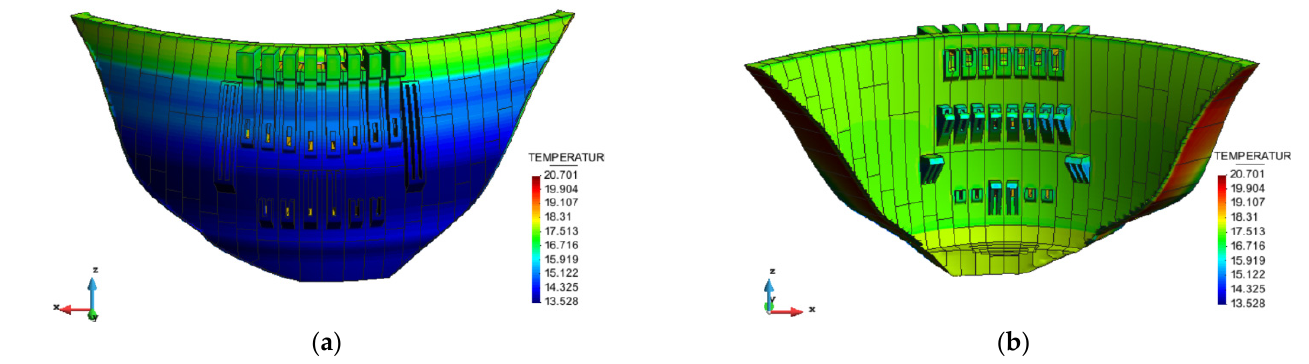
Figure 16. Cloud map of quasi-stable temperature field distribution of the dam in April (unit: °C). ( a ) Upstream face; ( b ) Downstream surface.